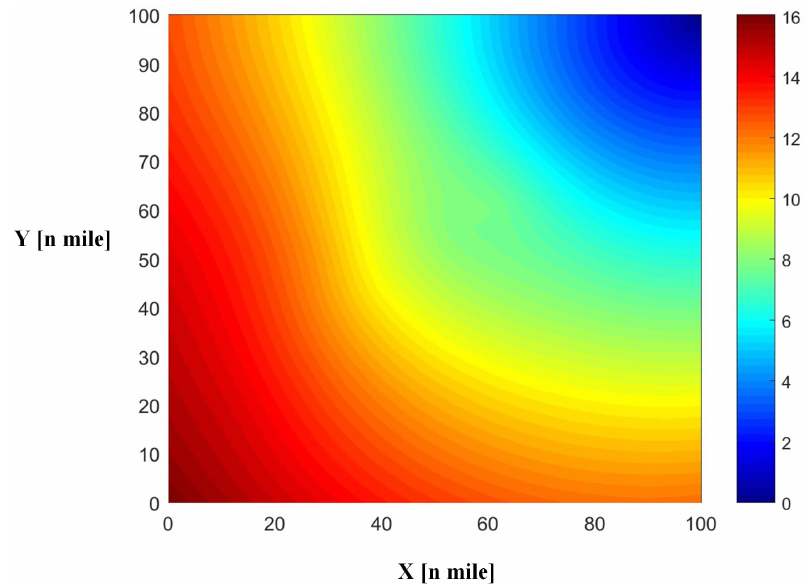
Figure 4. Two-dimensional superposition field after